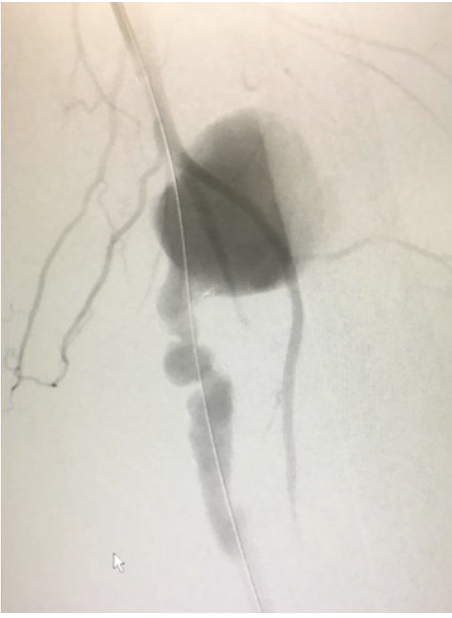
Figure 5: Intraoperative angiogram showing complete resolution the left superficial femoral artery pseudoaneurysm after stents